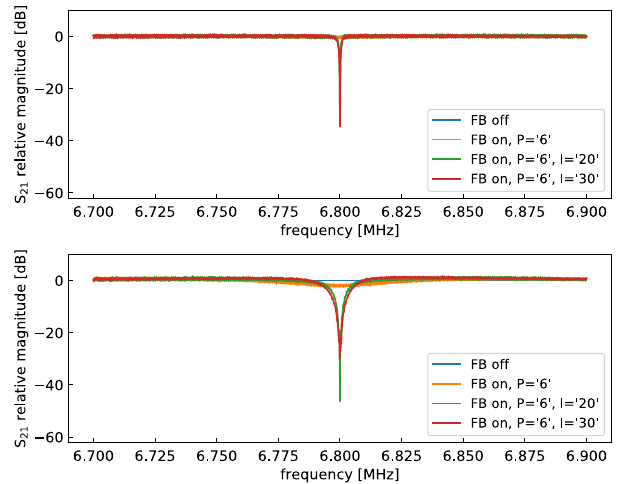
FIG. 24. (Top) Distorted gap voltage waveform when only the feedback for ( h ¼ 1 ) is closed and the other harmonics ( h ¼ 2 … 8 ) are open. (Bottom) Gap voltage waveform with the feedback loops closed for all harmonic ( h ¼ 3 ) of the driven harmonic has a large amplitude of 0.8 kV, and the second harmonic ( h ¼ 2 ) has an amplitude of a few percent of the driven harmonic.